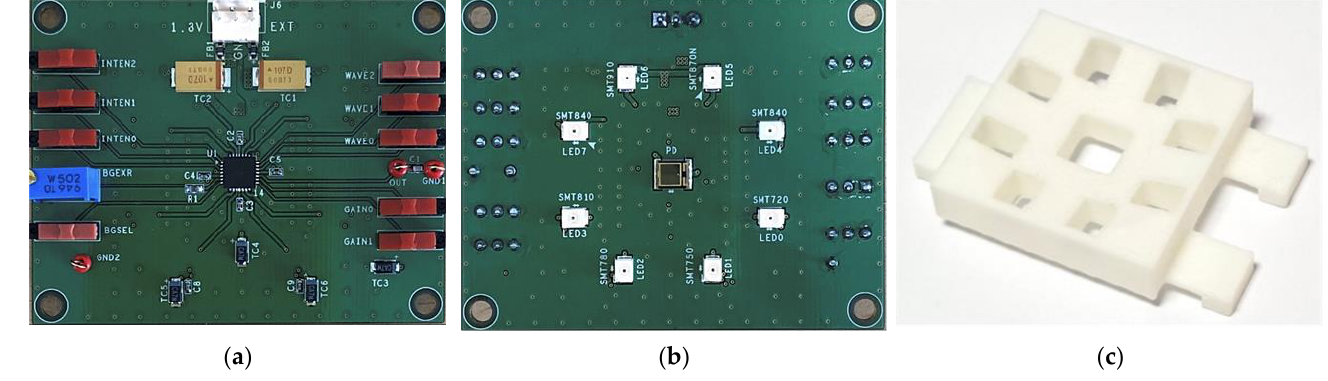
Figure 16. PCB ( a ) front face, ( b ) back face, and ( c ) chassis built by a 3D printer.